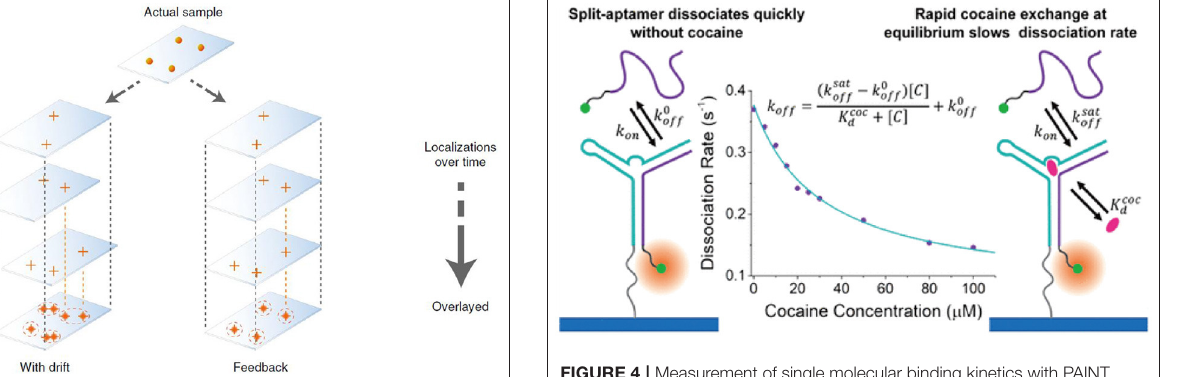
FIGURE 3 | Active SMLM is achieved with better drift correction to improve the resolution without PSF engineering or change of fluorophores (Coelho et al., 2020, 2021). It was shown that using an actively stabilizing microscope, the lateral spatial drift could be reduced down to ∼ 1nm using self-calibrated piezostage and anti-shaking algorithms. This can be done without relying on complicated hardware and the entire process can be completed in 2 weeks. Copyright with permission from Nature Publishing Group.